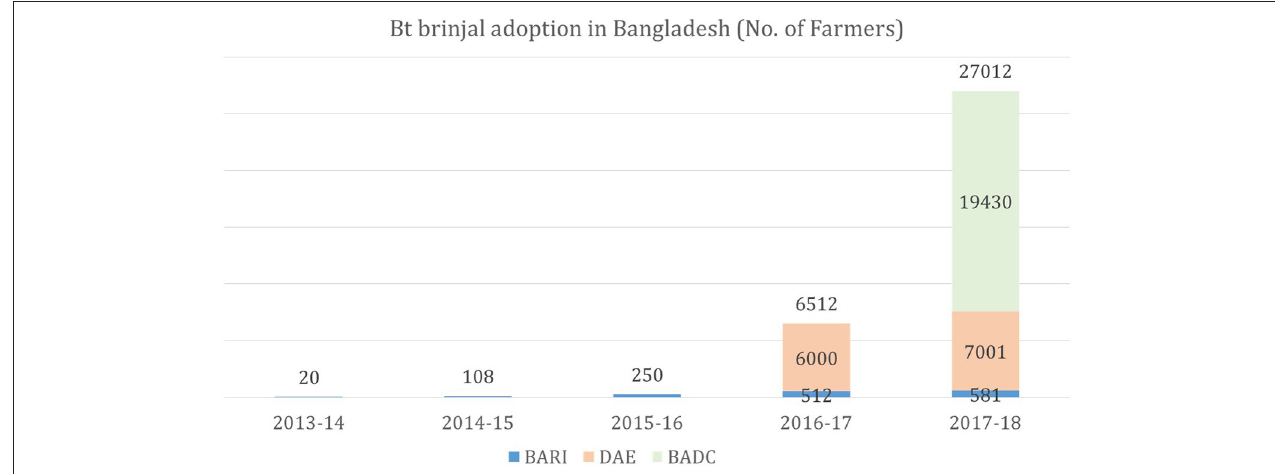
FIGURE 1 | Yearly adoption rate of Bt brinjal in